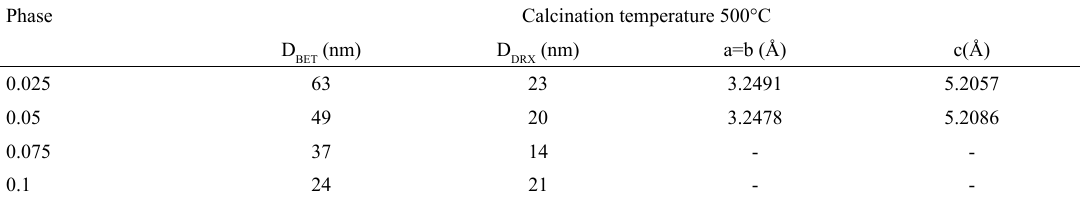
Table 1: Particle size, crystallite size, and lattice parameters a, b and c of samples doped with different concentrations of Mn as a function of the calcination temperature of 500°C, for 1 hour.